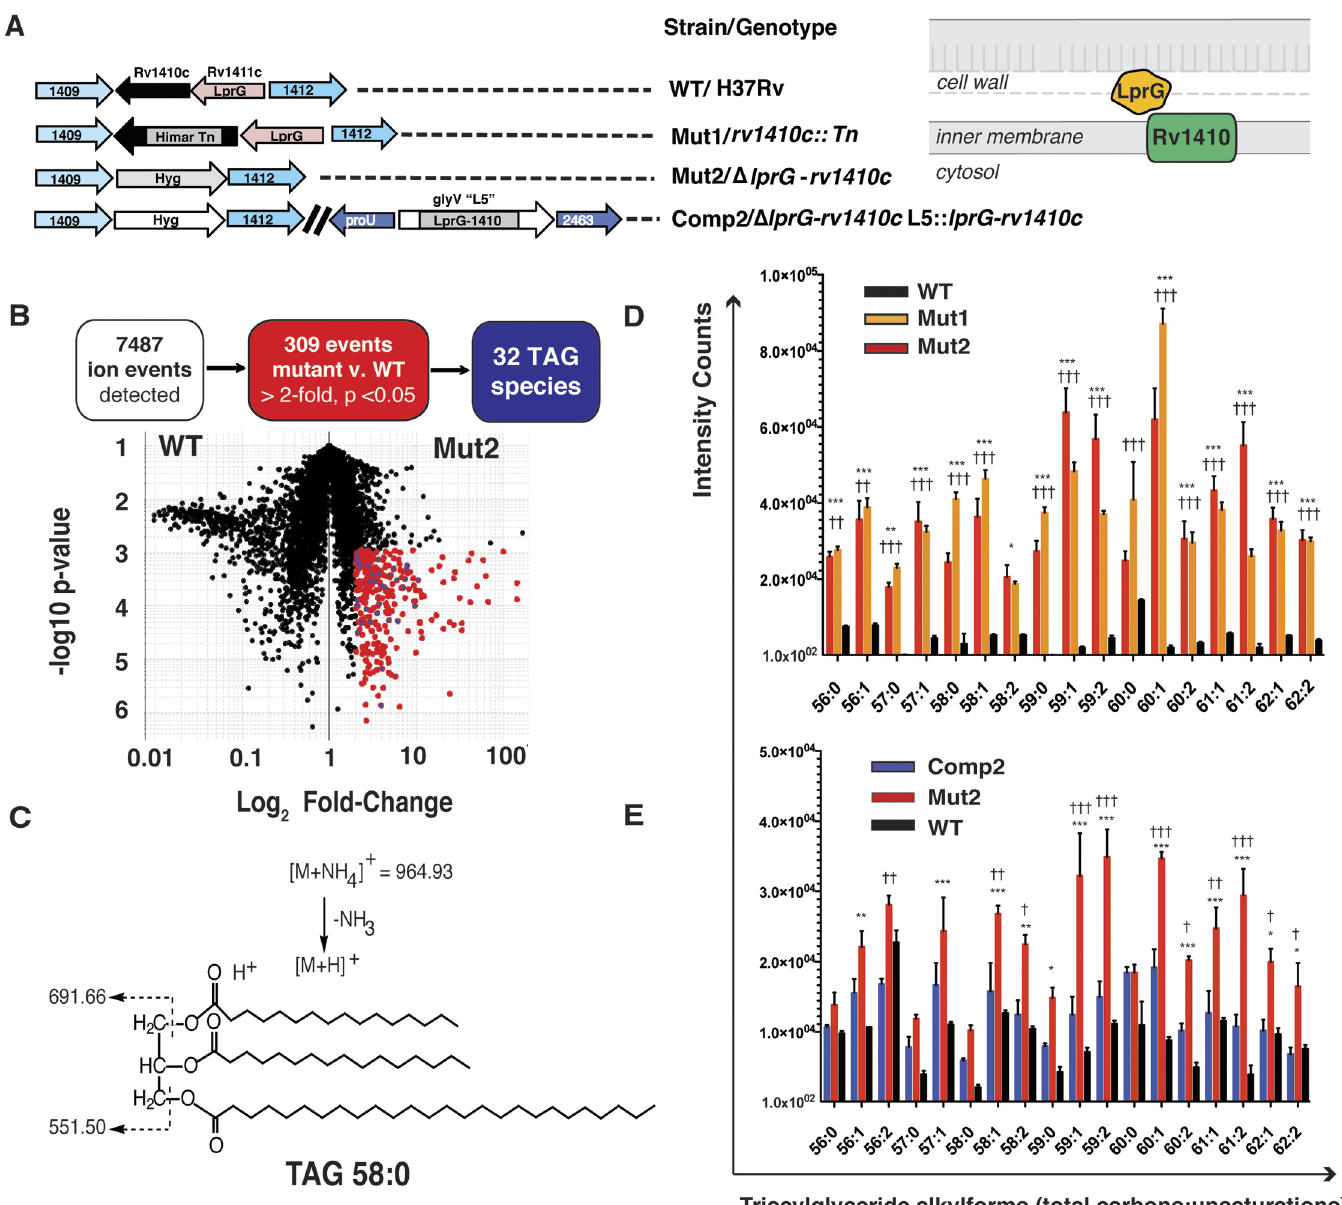
Fig 1. Lipidomics show that loss of LprG-Rv1410 results in triacylglyceride (TAG) accumulation in Mtb . (A, left) Strains used in this study. (A, right) Schematic showing predicted localization of proteins encoded by genes manipulated in this study. (B) Positive mode comparative lipidomics analysis from stationary phase M . tuberculosis Mutant 2 (Mut2) and parental wild-type (WT) strains yielded 7487 total events (black and red) with 309 (red) that meet change criteria of a two-fold increase in Mut2 compared to WT at a corrected p < 0.05 (student ’ s paired t-test, Gene Pattern, Broad Institute). Each dot represents the mean intensity over three biological replicates for a given molecular event in Mut2 compared to WT. For thirty-two of these the m/z values match the expected masses of TAG alkylforms (blue) detected as ammonium and hydrogen adducts. (C) Collision-induced dissociation mass spectrometry of a representative TAG (TAG 58:0, m/z 564.93). (D-E) Mean intensity values for molecular events mapping to TAG isoforms (ammonium adducts) with the indicated total number of carbons:unsaturations found in all alkyl chains in (D) WT, Mut1 and Mut2 and (E) WT, Mut2, and Complement (Comp2) strains. Error bars show mean +/- SD. * p < 0.05, ** p < 0.01, *** p < 0.001, in (D) Mut1 ( † ) or Mut2 ( * ) vs. WT and (E) WT ( * ) or Comp2 ( † ) vs. Mut2; 2-way ANOVA with Bonferroni post-test